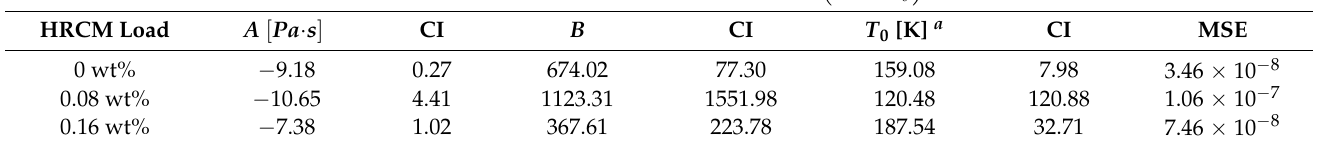
Table A2. Fitting parameters ( A , B , T 0 ), confidence intervals (CI), and mean square error (MSE)